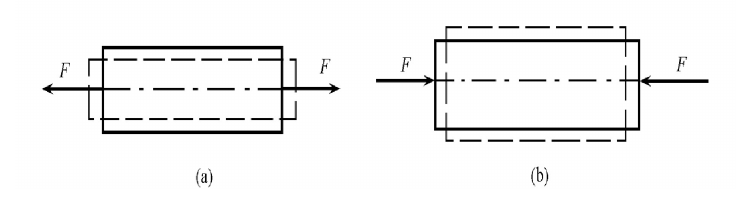
Fig. 4 Tension and compression.